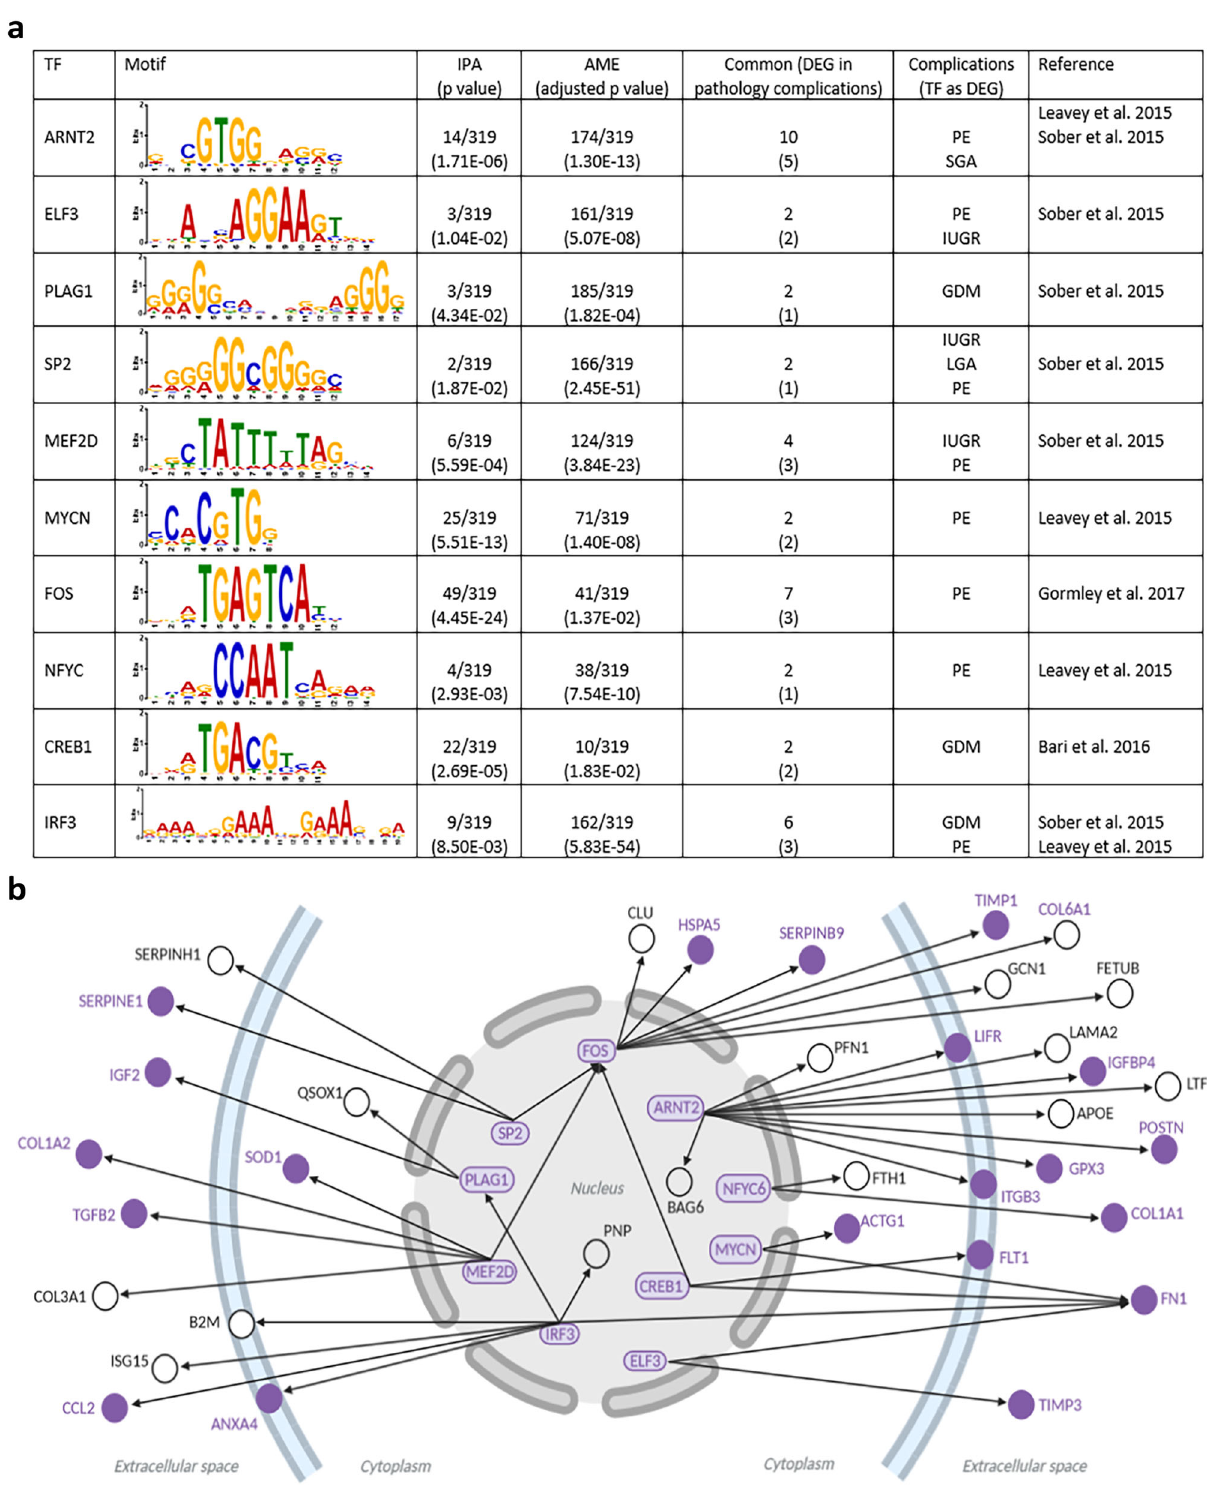
Fig. 5 Transcription factors dysregulated in pregnancy complications identi fi ed as possible regulators of genes encoding secreted placental proteins. a Table showing the ten transcription factors with altered expression in pregnancy complications and with binding sites enriched at the promoters of genes encoding proteins in the placental secretome map. b Regulatory network built with the ten transcription factors listed in a . The ten transcription factors and their targets that are differentially expressed in pregnancy complications are highlighted in purple. Location of the target proteins is according to their main cellular/extracellular compartment indicated by IPA. The graph was generated using